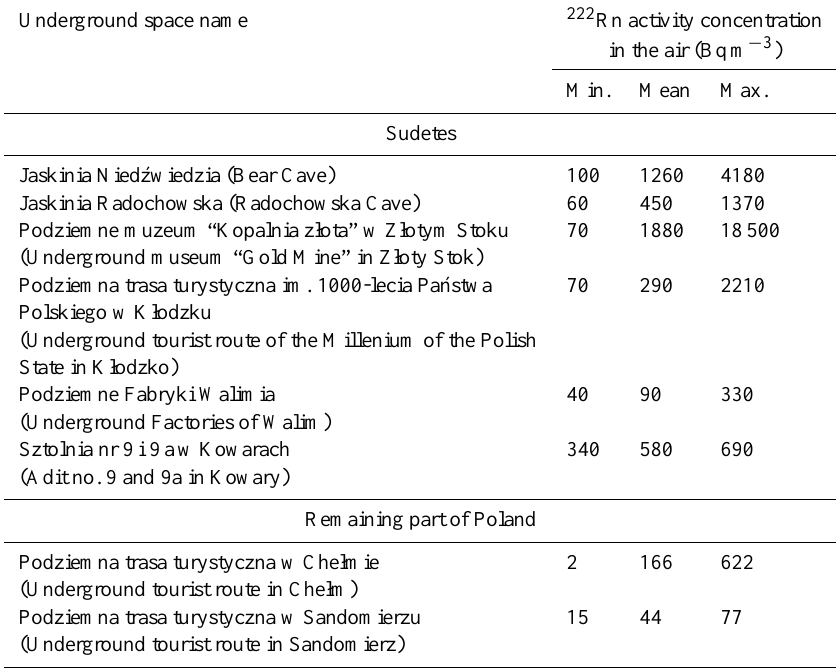
Table 1. Mean and extreme values of mean monthly radon ( 222 Rn) concentration in the air of selected underground tourist facilities in Poland (according to Chru´scielewski and Olszewski, 2000; Chibowski and Komosa, 2001; Przylibski, 2002). Underground space name 222 Rn activity concentration in the air (Bqm − 3